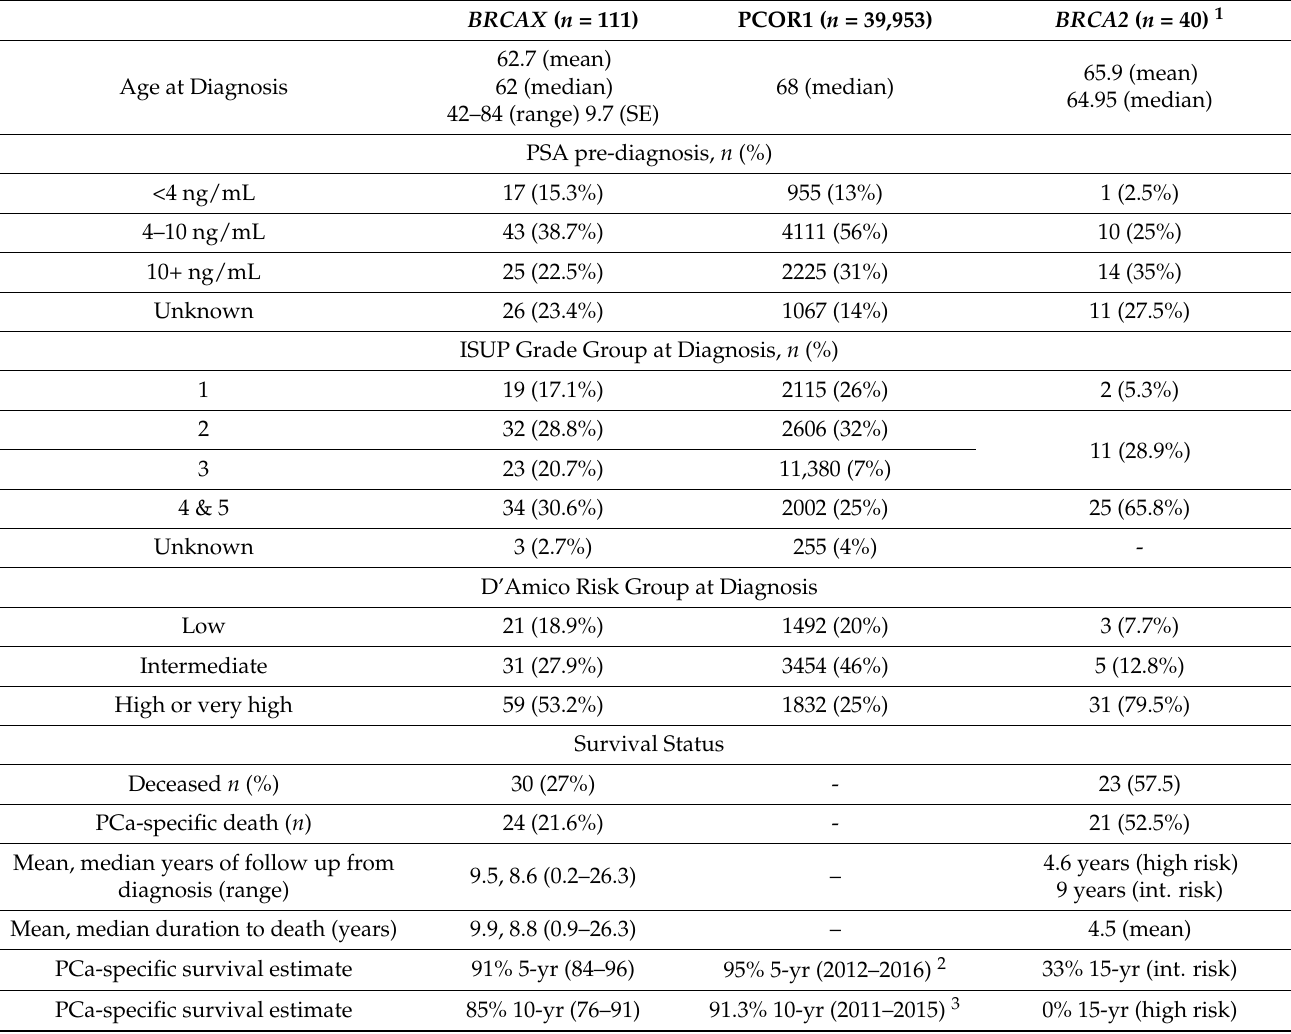
Table 4. Clinical features of the BRCAX cohort, PCOR cohort and BRCA2